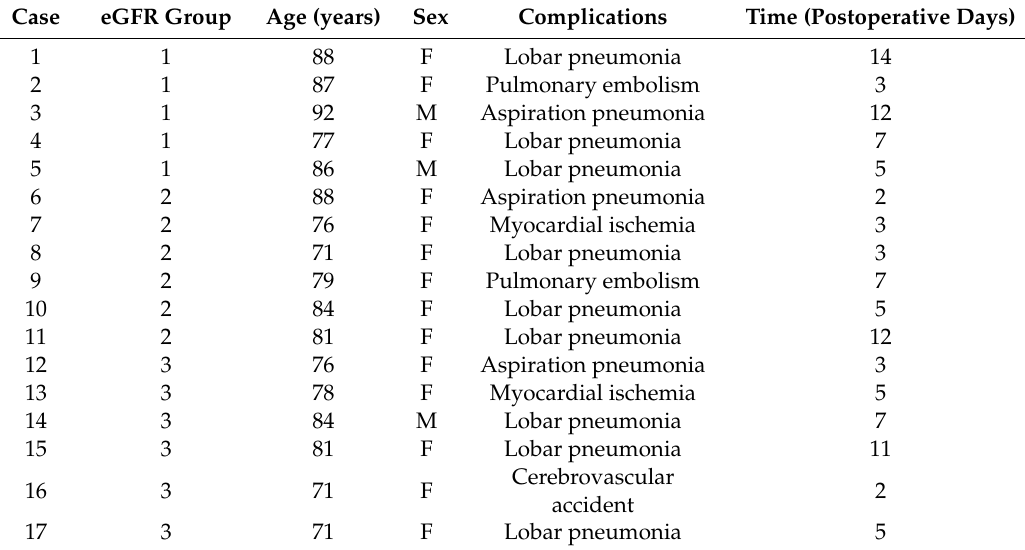
Table 4. Medical complications.